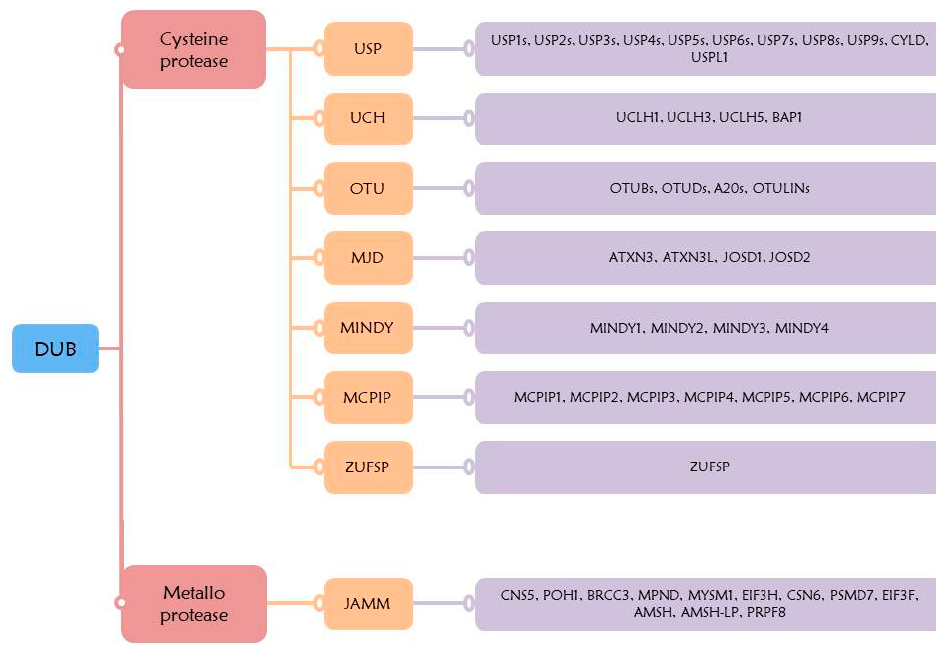
Figure 3. Overview of the DUB family. The DUB family is divided into two subfamilies, based on the enzymatic cleavage mechanism. The cysteine protease family consists of USP, UCH, OTU, MJD, MINDY, MCPIP, and ZUFSP. Metalloprotease family consists of